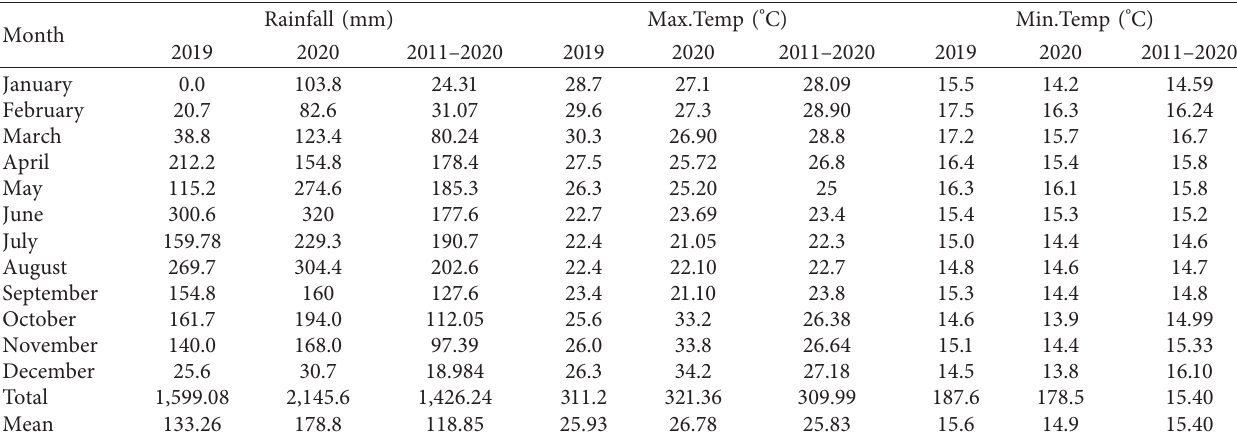
Figure 1: Map of the experimental subdistrict in Wolaita Zone, southern Ethiopia. Table 1: Ten-year (2011–2020) monthly rainfall (mm) and monthly maximum and minimum temperature ( ° C) during the rainy seasons at Sodo Zuria District of Wolaita Zone, southern